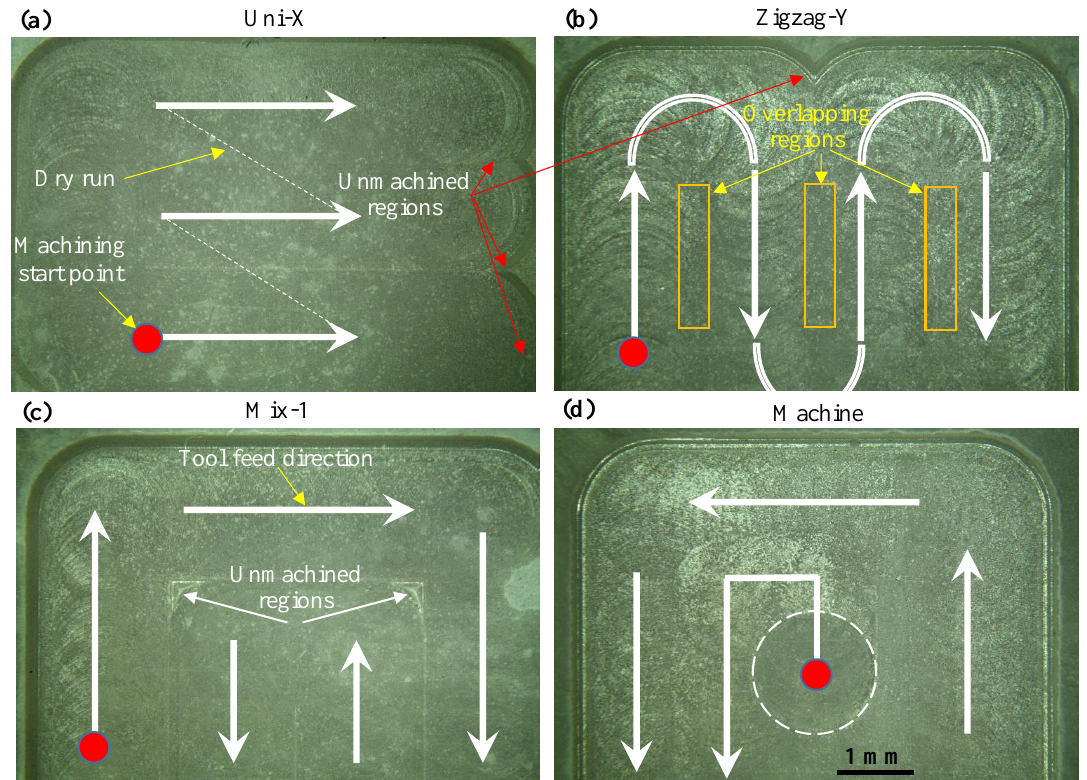
Figure 12. Microscopic images of the pockets machined at ( a ) Uni-X strategy, ( b ) Zigzag-Y strategy, ( c ) Mix-1 strategy and ( d ) Machine strategy.